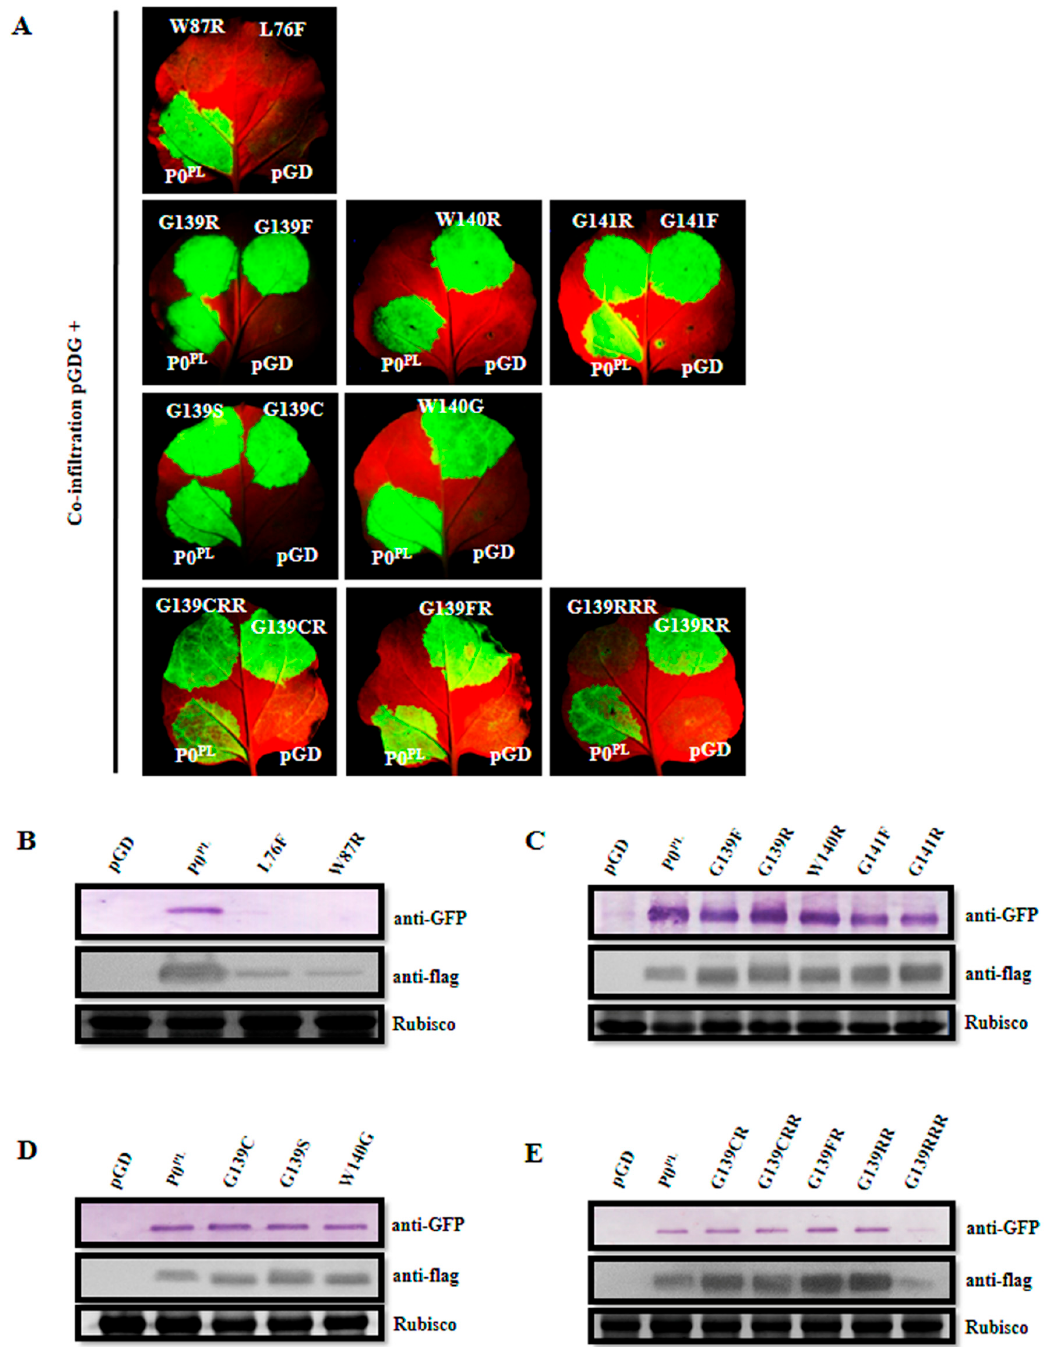
Figure 1. Suppression of local RNA silencing by the mutants of P0 protein of PLRV (P0 PL ) in F-box-like motif and G139/W140/G141-like motif. ( A ) Evaluation of suppression of local RNA silencing in wild-type Nicotiana benthamiana leaves co-infiltrated with Agrobacterium harboring pGDG and empty pGD vector, or P0 PL (wild-type), or P0 mutants, at 3 dpi under long-wavelength UV light. The bottom-right side of leaves shows GFP expression for pGDG plus pGD, the bottom-left side of leaves shows GFP expression for pGDG plus P0 PL , and both top-right and left side of the leaves show GFP expression for pGDG plus P0 PL mutants. ( B – E ) Western blot analyses of proteins extracted from the infiltrated leaf patches at 3 dpi using the specific antibody for GFP (anti-GFP) and flag (anti-flag). Rubisco stained with Coomassie brilliant blue was used as a loading control and is shown in the lower panel.